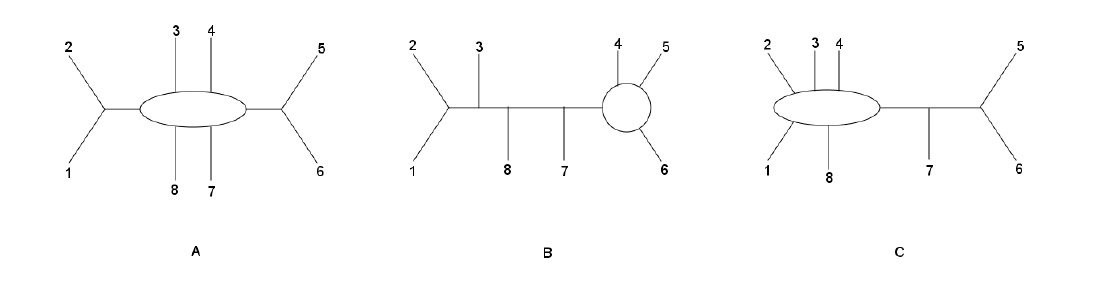
Figure 7 . Some one loop Feynman diagrams cover more than one e(cid:11)ective